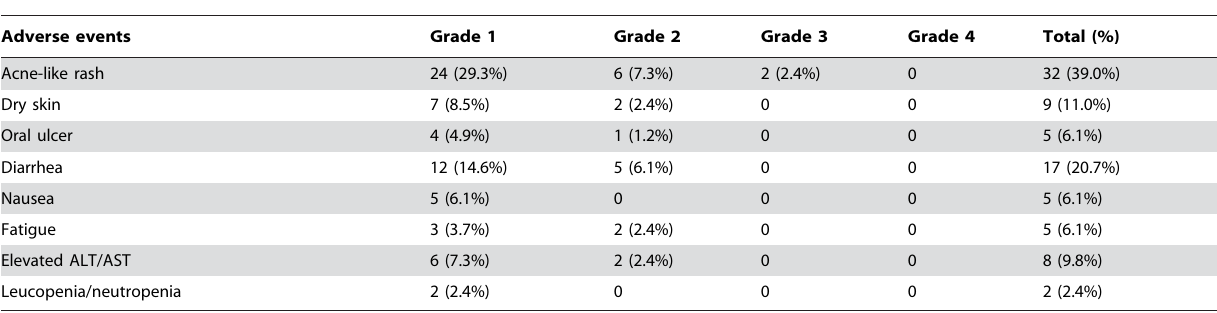
Table 3. Summary of the treatment-related adverse